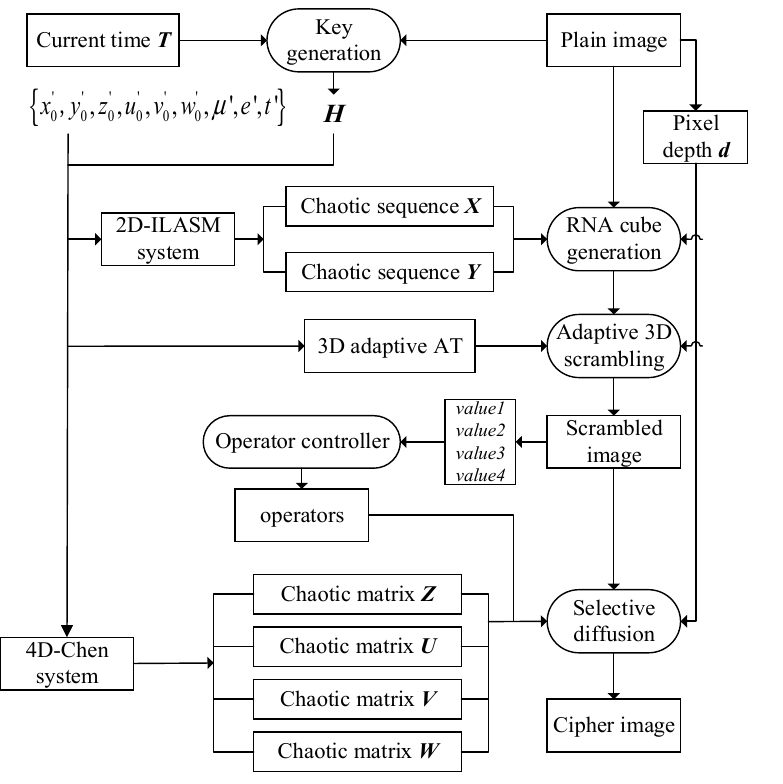
Figure 7. The encryption flowchart of the proposed algorithm.